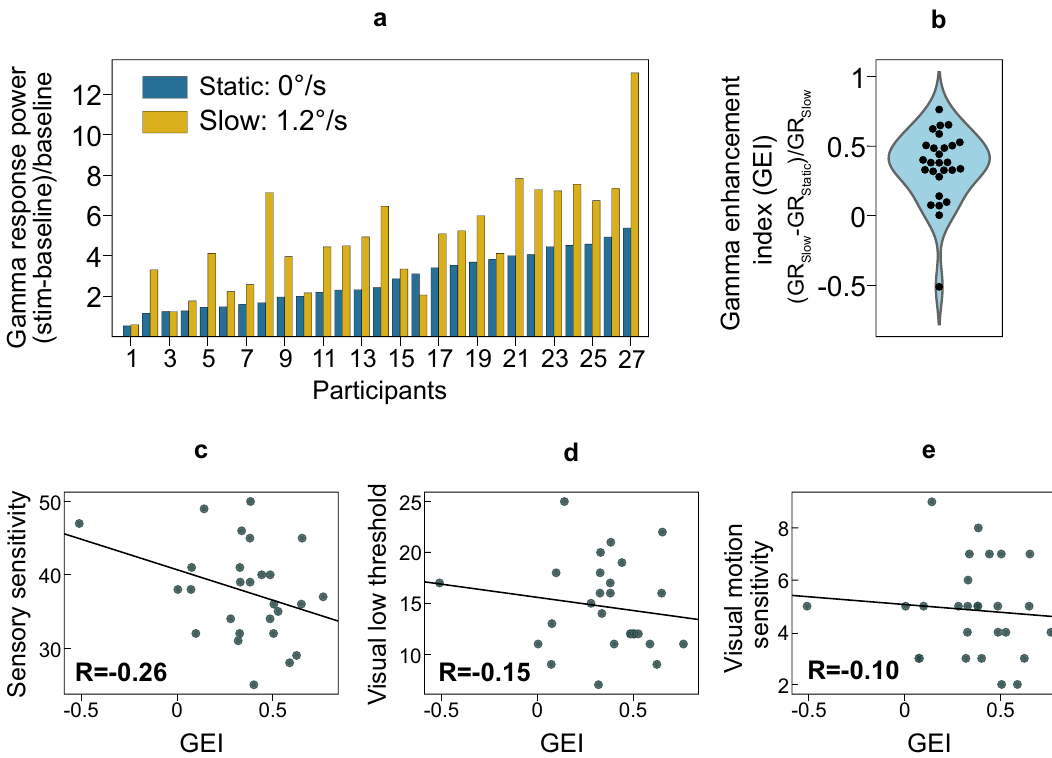
Figure 3. Velocity-related enhancement of the gamma response (GR) power with transition from static to slowly moving gratings (i.e., Gamma Enhancement Index, GEI) and its correlations with Adolescent/Adult Sensory Profile (A/ASP) scales. ( a ) Individual GR values in the ‘static’ and ‘slow’ motion conditions. ( b ) Violin plot of the GEI values. ( c – e ) Correlations between the GEI and three A/ASP sensitivity scales: ( c ) ‘Sensory Sensitivity’, ( d ) ‘Visual Low Threshold’, ( e ) ‘Visual Motion Sensitivity’. R’s are Spearman rank correlation coefficients, *p <